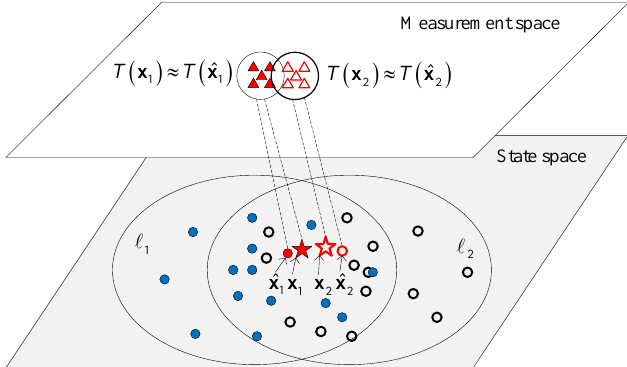
Figure 2. A sketch diagram to show the measurements affected by two targets are associated with two tracks. Solid triangles denote the associated measurements of the target x 1 and the particle ˆ x 1 , Hollow triangles denote the associated measurements of the target x 2 and the particle ˆ x 2